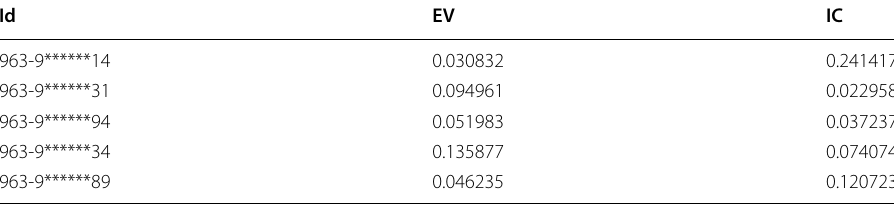
Table 6 Sample of EV and IC measures